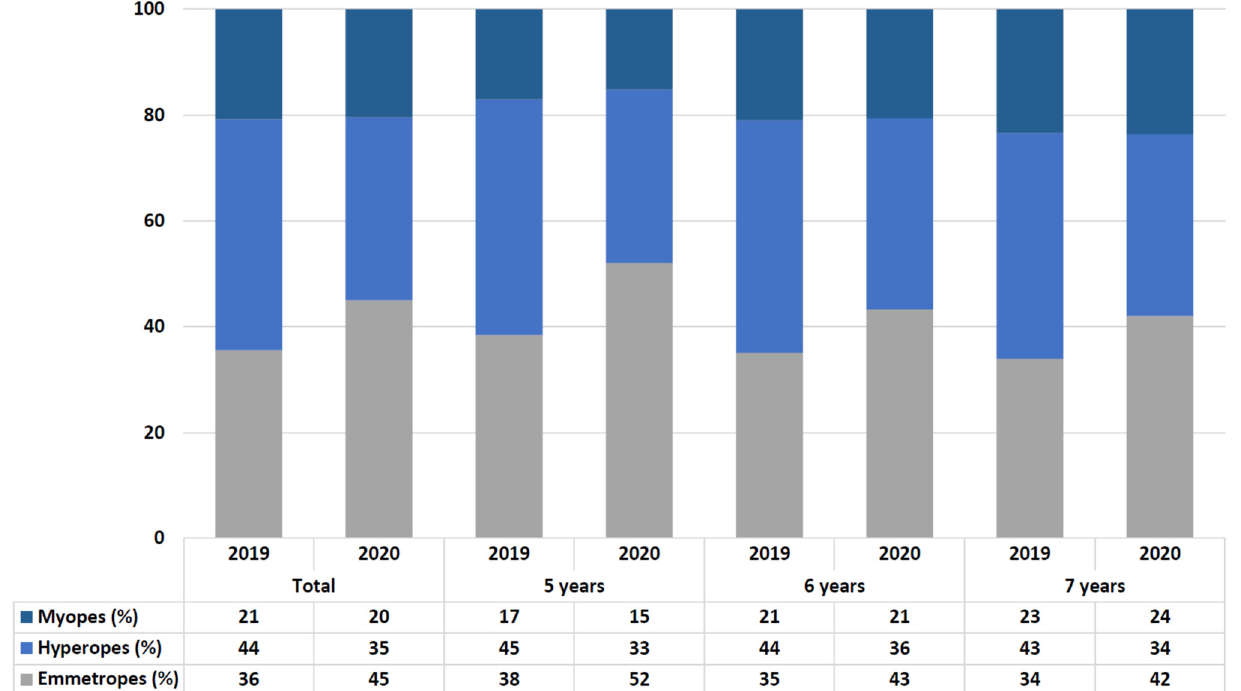
Figure 1. Comparison in the rate of refractive errors in all the children and by ages.